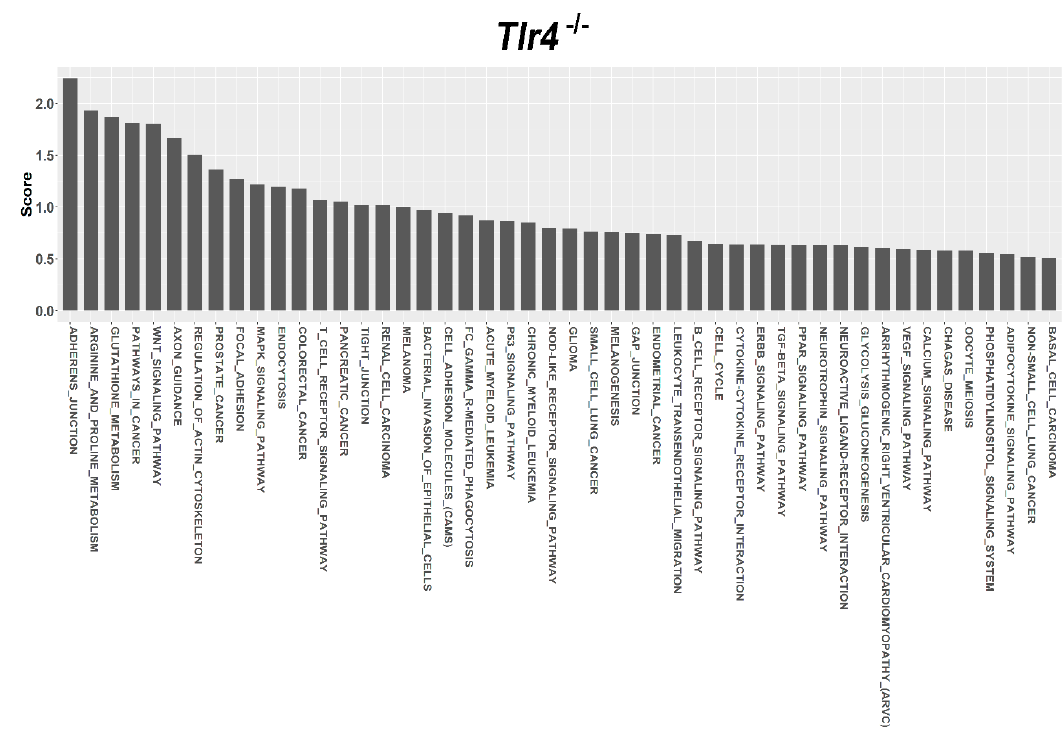
Figure 8. Pathway ranking summery of the genes by the dysregulated miRNAs from miRSystem database during weight reduction in Tlr4 − / − mice. These pathways were annotated according to KEGG.